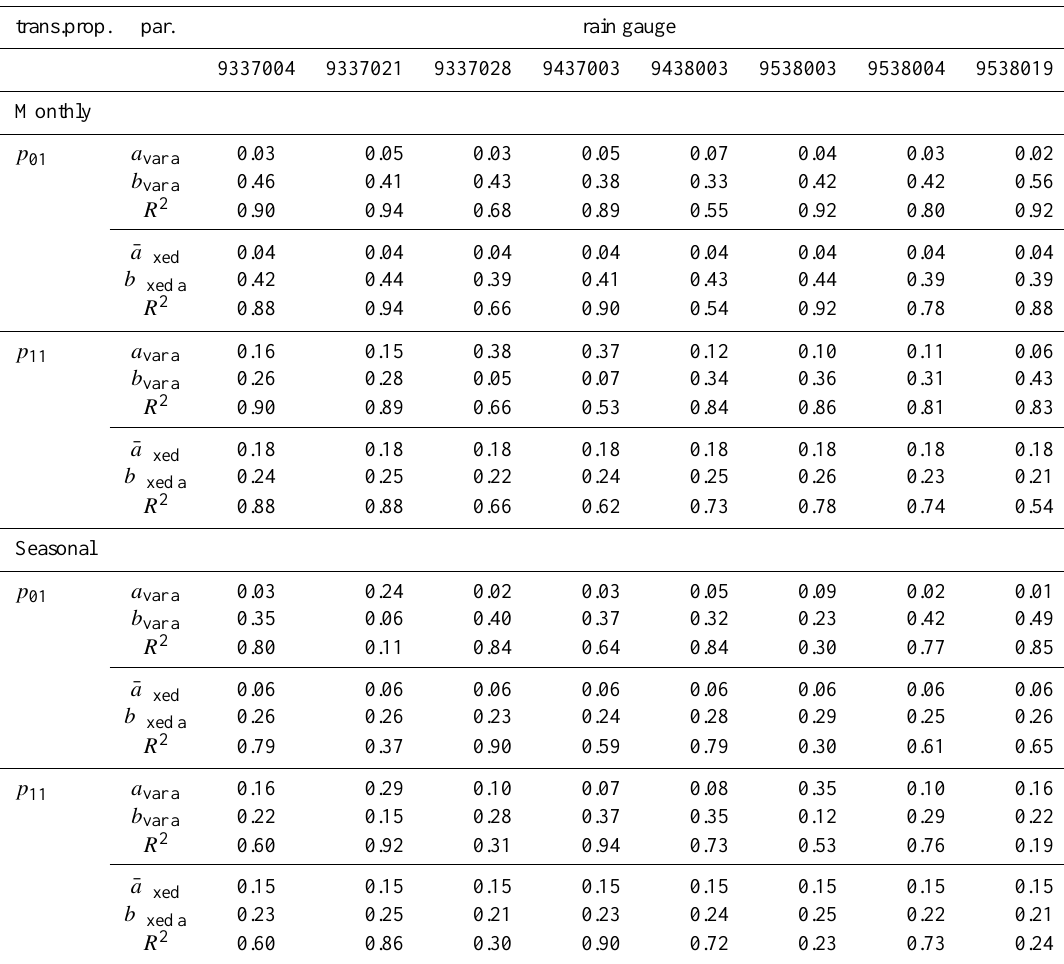
Table 1. Markov properties for both transition probabilities p 01 and p 11 for the eight rain gauges of the Pangani basin for Masika season, on monthly and seasonal